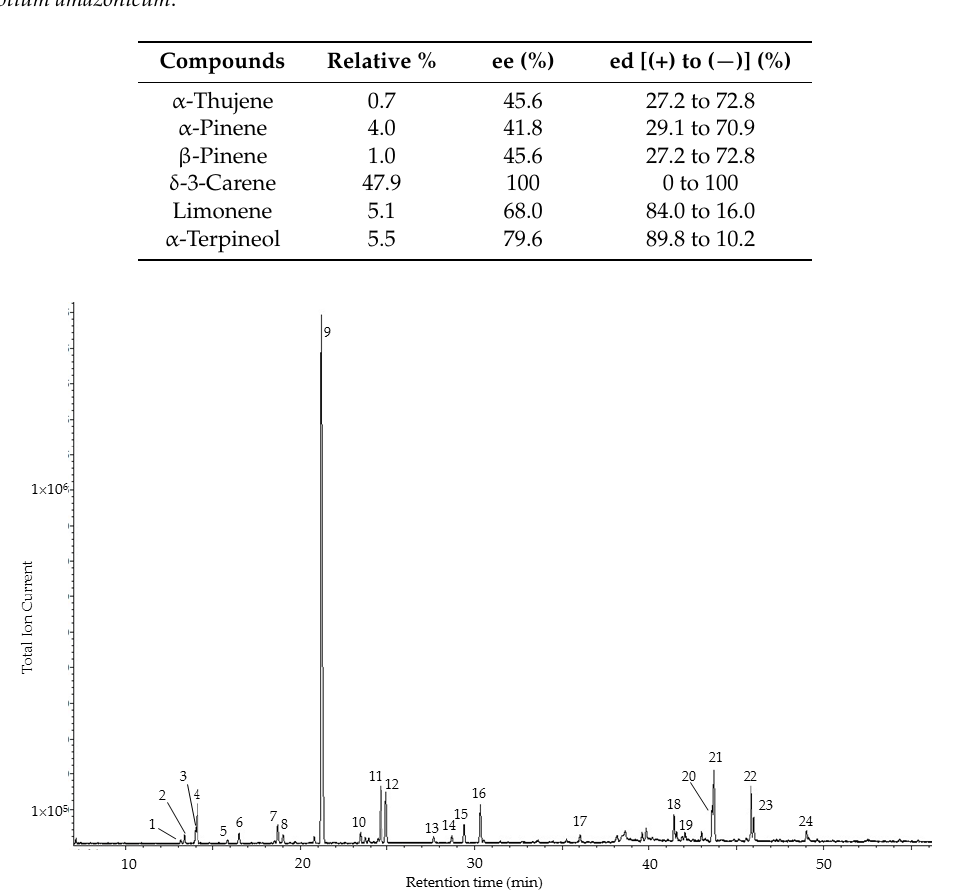
Figure 2. Chiral gas chromatogram of the oleoresin essential oil of Protium amazonicum . 1,